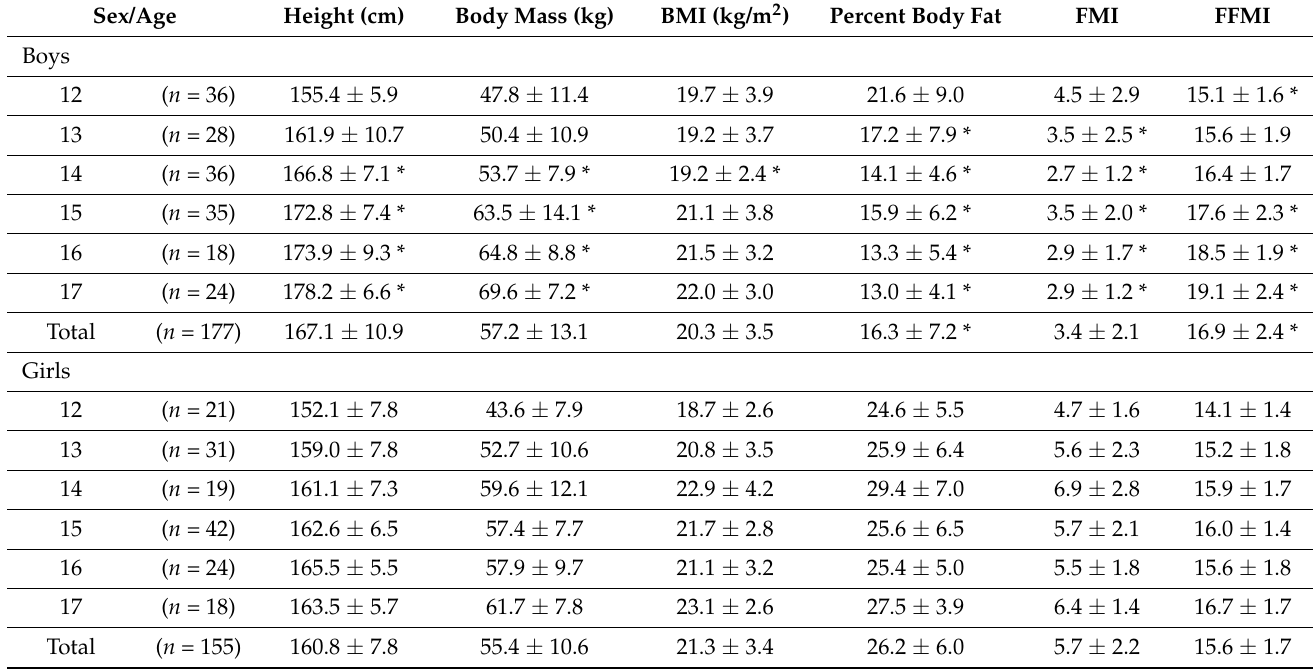
Table 1. Descriptive participant characteristics.